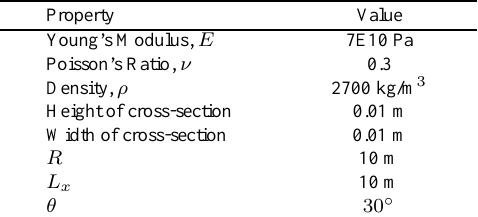
Table 3 Material and geometry for the strip of 5 rectangular